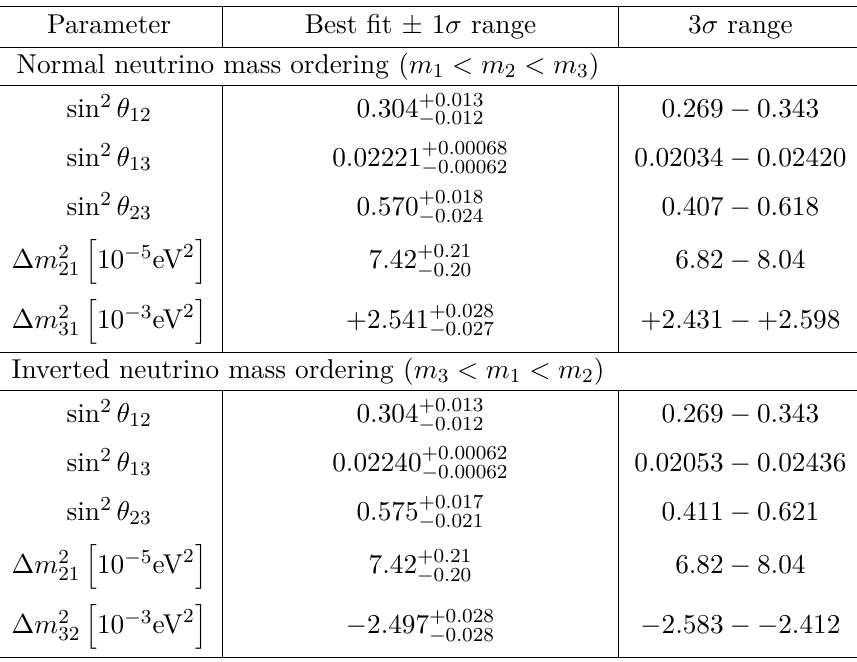
Table 3 . Experimental data of neutrino oscillation parameters from NuFIT 5.0 used in the numer- ical analysis [55].